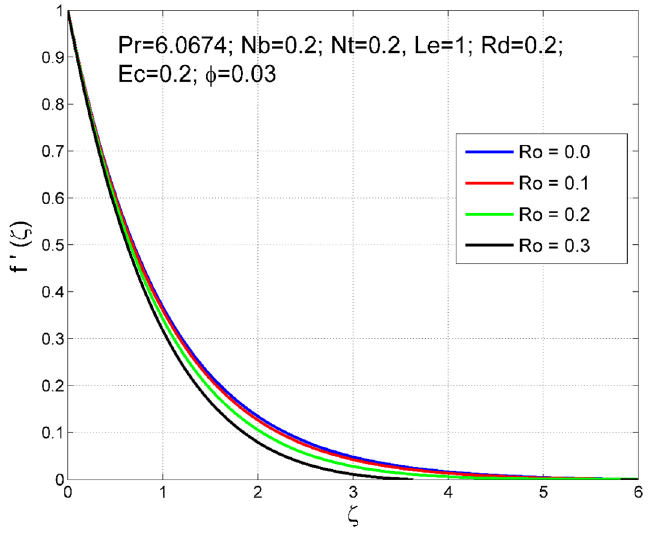
Figure 2. Effect of Ro on f ′ (ζ)